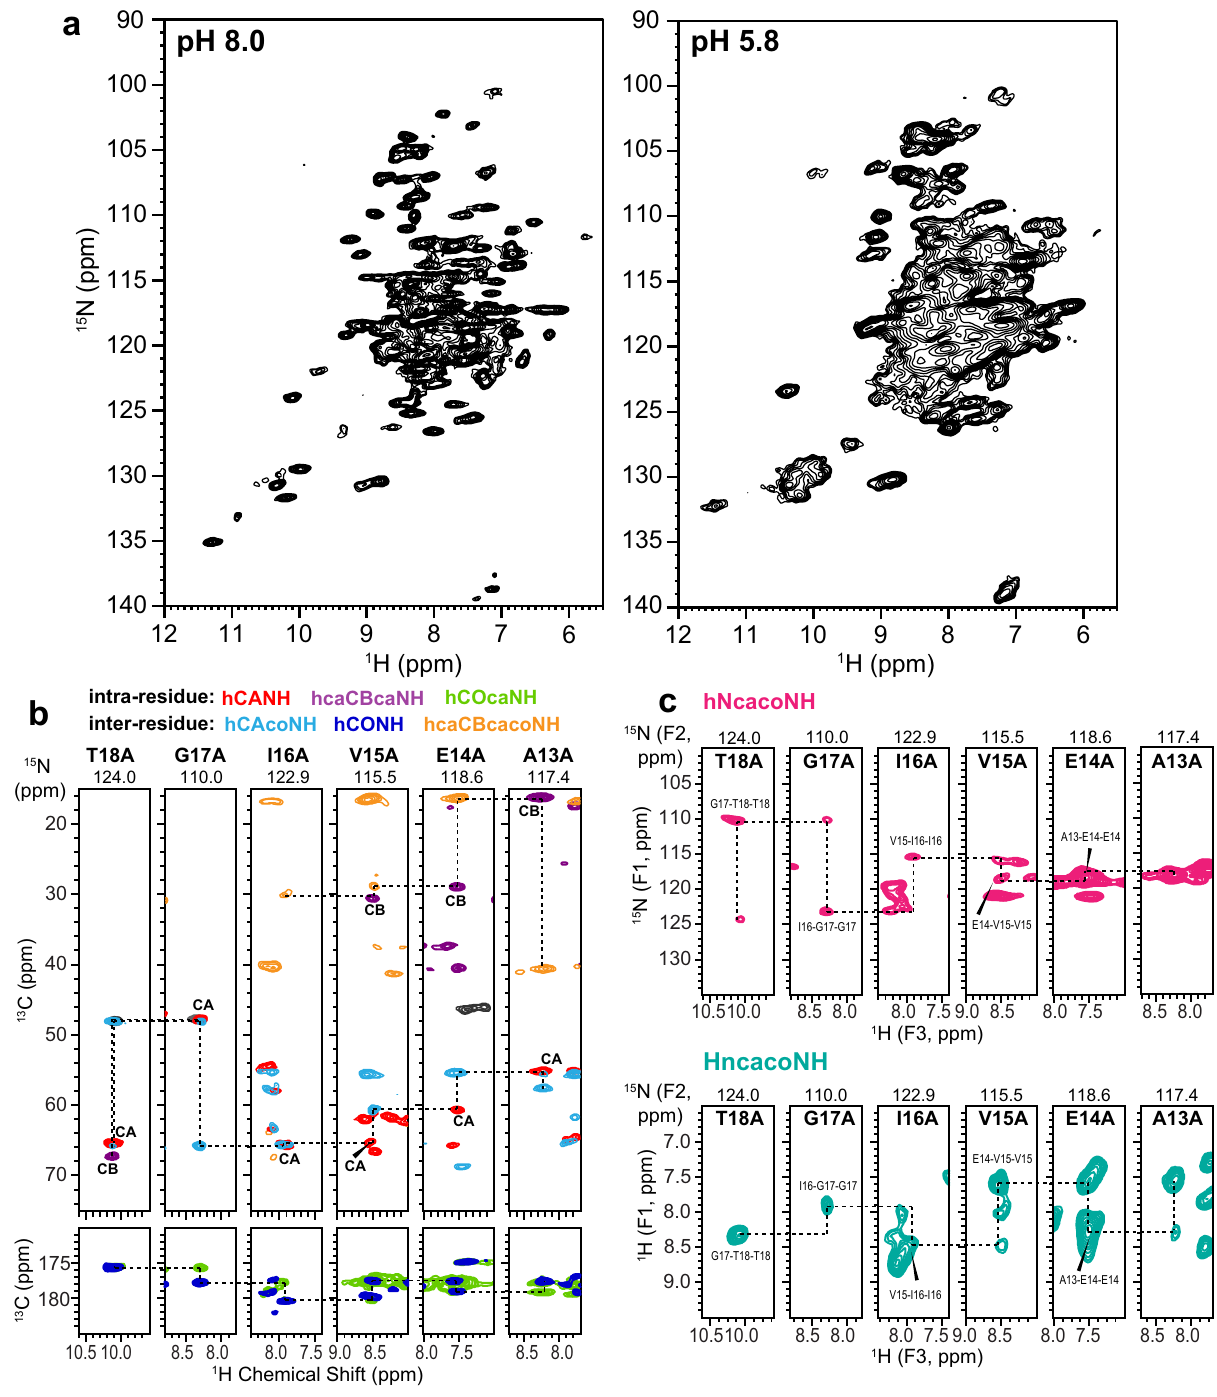
Fig. 2 2D and 3D 1 H-detected MAS correlation spectra of TPP-bound EmrE in DMPC bilayers for resonance assignment. a 2D hNH spectra of the protein at pH 8.0 compared to pH 5.8. The spectral linewidths are narrower at high pH, indicating higher structural homogeneity. b Six 1 H – 13 C – 15 N 3D correlation spectra to obtain intra-residue and inter-residue peak connectivities. The strips for residues T18 to A13 in subunit A are shown. The aliphatic 13 C strips overlay four 3D spectra whereas the carbonyl 13 C strips overlay two 3D spectra. Negative intensities in the hcaCBcaNH and hcaCBcacoNH spectra are shown in gray. Glycine residues show a negative CA peak rather than a positive CB peak. c Inter-residue 3D NNH and HNH correlation spectra. All spectra were measured under 55 kHz MAS on a 600 MHz NMR out of four phenylene rings tangential to the bilayer normal. In one side of the helical bundle. This closed-on-one-side con fi g- comparison, at low pH the TM helices are oriented at very dif- uration pushes the ligand towards the opposite end of the helical ferent angles with respect to each other. In particular, the bundle, where the C-terminal end of TM3A is now splayed open N-terminal end of TM3A approaches the C-terminal end of from the N-terminal end of TM3B. The resulting shallow and TM3B (Supplementary Fig. 7b), which closes off water access on open binding site at low pH exposes the ligand (Supplementary